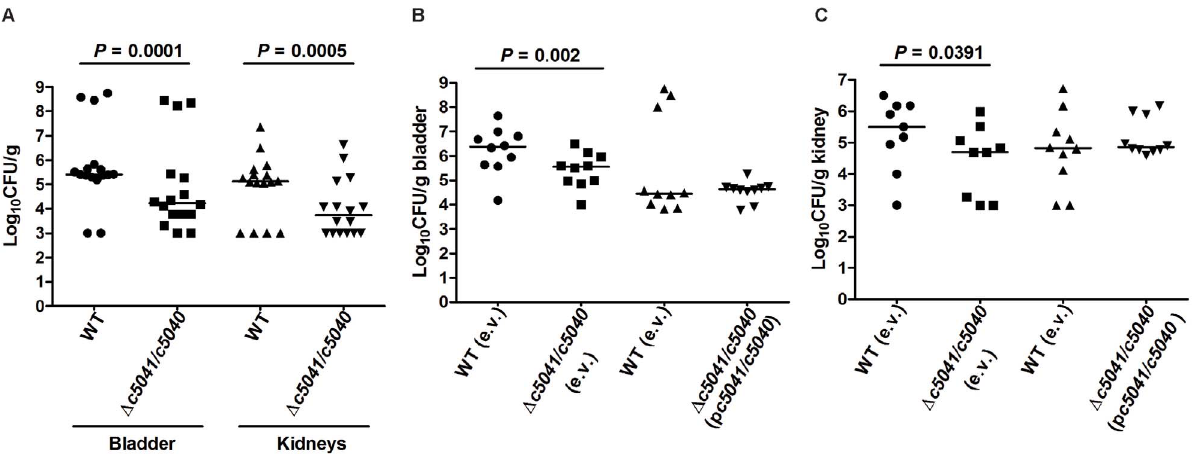
Figure 2. Deletion of c5041 / c5040 reduces the colonization of the murine urinary tract by UPEC strain CFT073. (A) The WT and D c5041 / c5040 ::Chl r mutant strains were mixed to a 1:1 ratio and approximately 2 6 10 9 CFU were transurethrally inoculated into female mice. Two days after infection, the mice were sacrificed and their bladders and kidneys were aseptically removed. WT and mutant bacteria were recovered by plating homogenized tissue samples on LB or LB containing chloramphenicol and their viable counts were determined. (B) and (C), for the in vivo complementation assay, a mixture of wild-type strain containing empty vector (e.v.) pGEN-MCS and mutant strain containing empty vector or wild- type strain containing empty vector and mutant strain containing complementation plasmid (p c5041 / c5040 ) were incolulated to female mice as in (A). Homogenized tissue samples (B, bladder; C, kidneys) were plated on LB with ampicillin or LB with both ampicillin and chloramphenicol. Each dot represents log 10 CFU/g in the bladder or kidney from an individual animal and the detection limit is 1000 CFU/g. Bars indicate the median log 10 CFU/g. A two-tailed Wilcoxon matched pairs test was performed, and the difference in colonization levels of WT and mutants was considered statistically significant if P , 0.05.